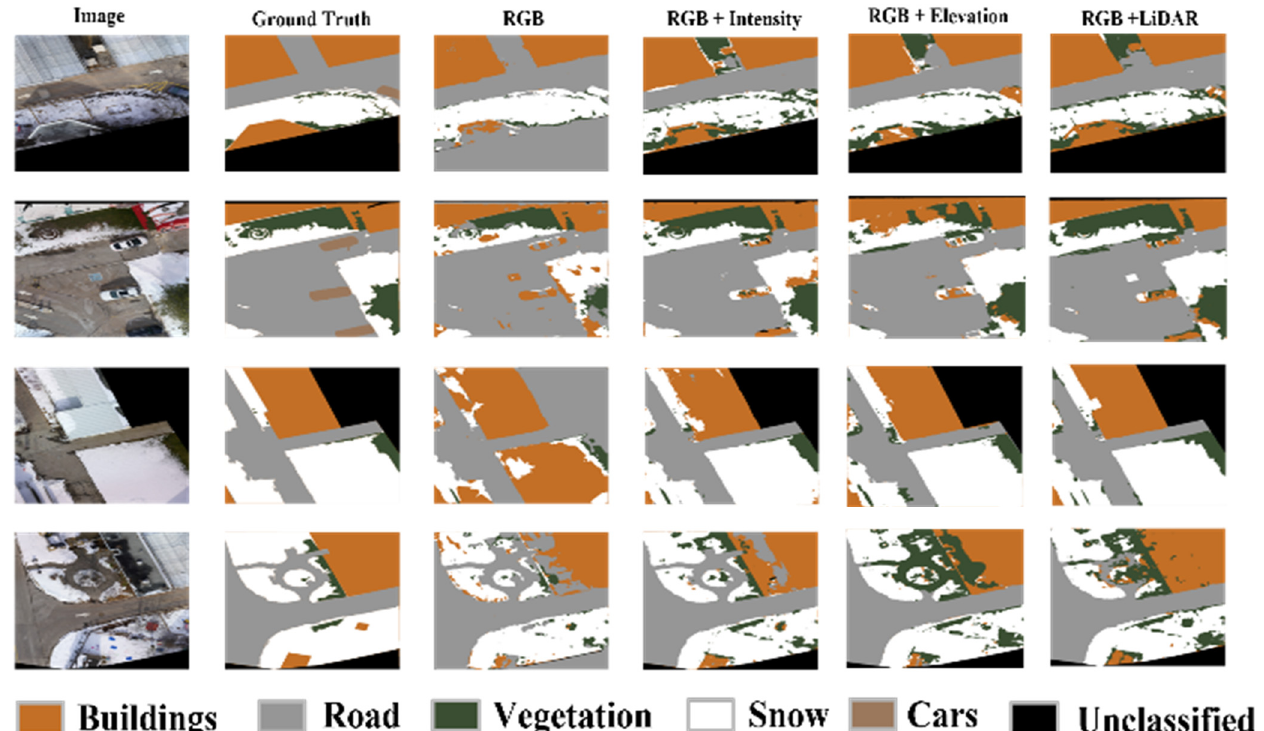
Figure 23. Comparison of the DCNN prediction results of the first dataset. Table 3. Comparison of indicator parameters for the four combinations using DCNN. Table 4. Comparison of indicator parameters for the four combinations using